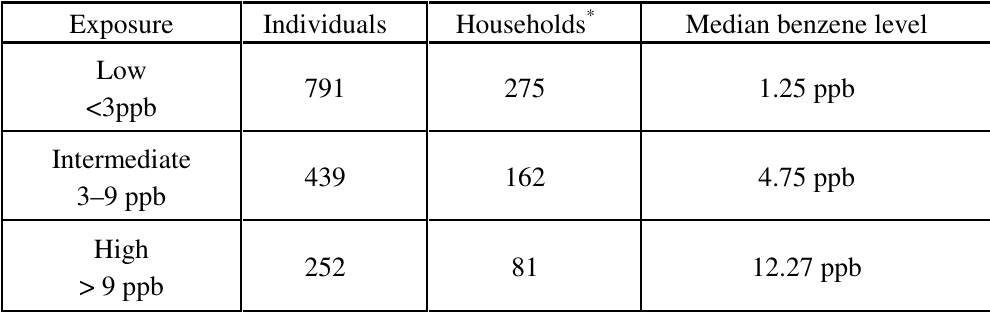
Table 3. Benzene Exposure by Grouping.